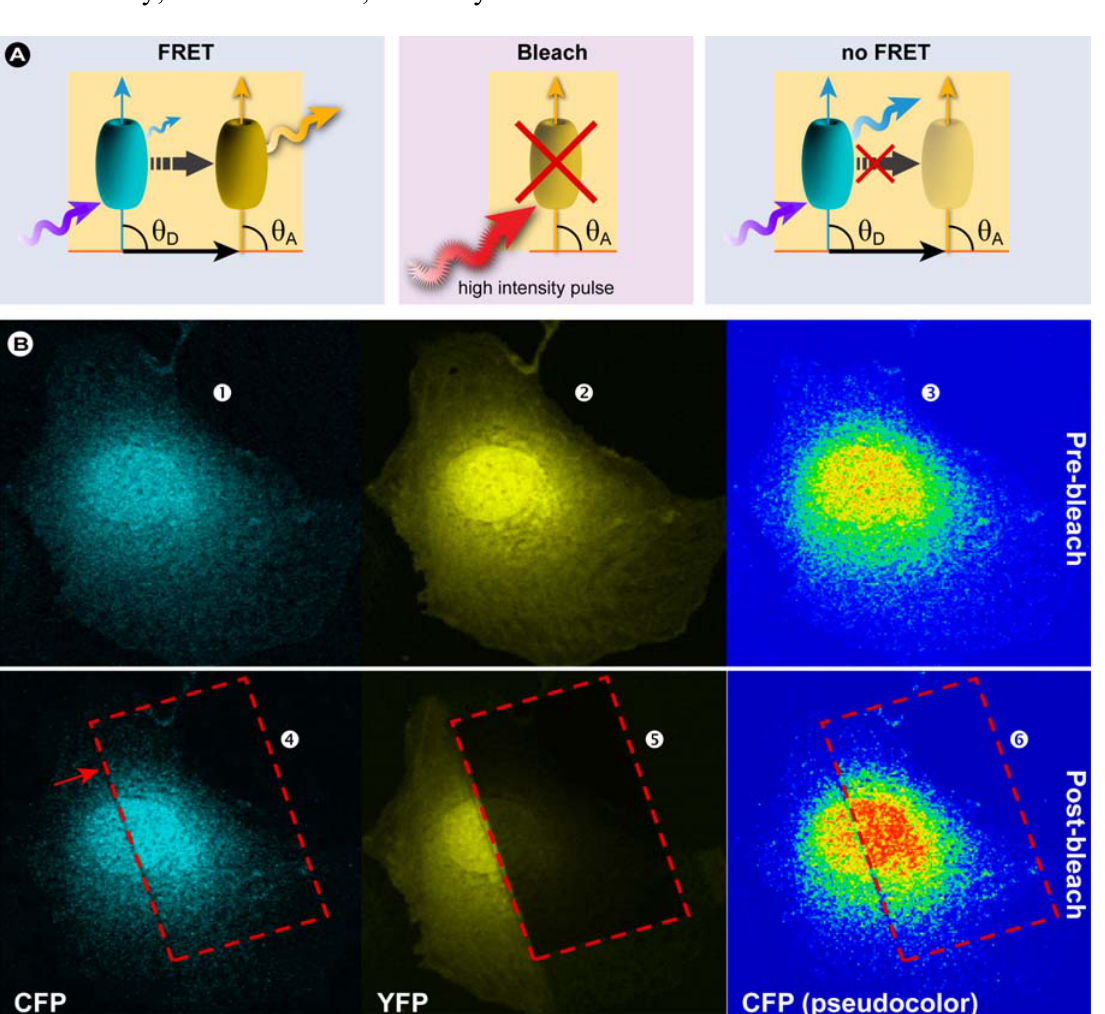
Figure 21. ( A ) Schematic representation of acceptor photobleaching. FRET occurs because the donor transmits part of its energy to the acceptor. As a control, the acceptor is bleached with high intensity light, until the majority of the acceptor molecules are irreversibly damaged. As a result, the donor emission will increase, since energy transfer is abolished. Depending on the efficiency of the acceptor bleaching, there will be little to no acceptor emission detectable. However, if no FRET occurred ( i.e. donor and acceptor molecules are too distant from each other) acceptor bleaching should have no effect on the fluorescence intensity of the donor molecule. ( B ) Example of acceptor photobleaching FRET, obtained via CLSM in a living HeLa cell co-expressing an eCFP (donor) and eYFP (acceptor) construct. CFP and YFP images were excited sequentially at 458 and 514 nm and emission recorded with adequate filter sets (  –  ). A region of the cell (red rectangle) was photobleached at 514 nm for 5 s  . Post-bleach images were captured simultaneously at 458 nm excitation (  –  ). FRET is visualized as an increase in CFP fluorescence  following YFP photobleaching  , which is more prominently visualized in the pseudo- colored image (compare  and  , which shows a distinct increase in red intensity values in the nucleus). Image courtesy of B. Giese and G. Müller-Newen, Institute for Biochemistry, RWTH-Aachen,